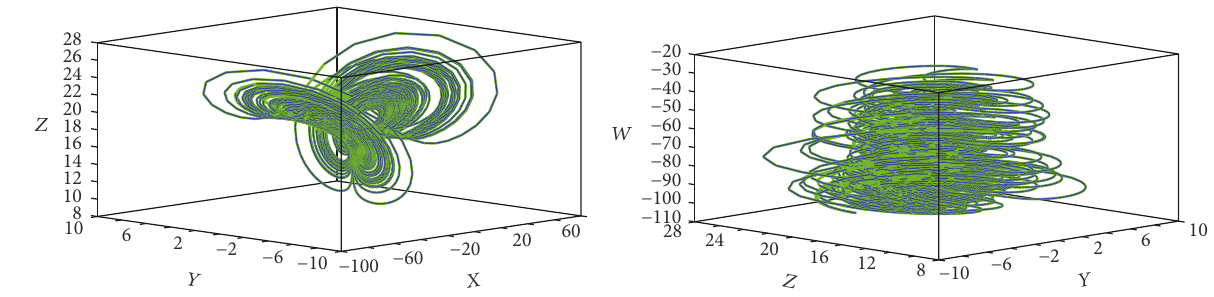
Figure 12: 3D phase portraits of NCS ( 𝑎 ̸= 0, 𝑏 = 0 ).